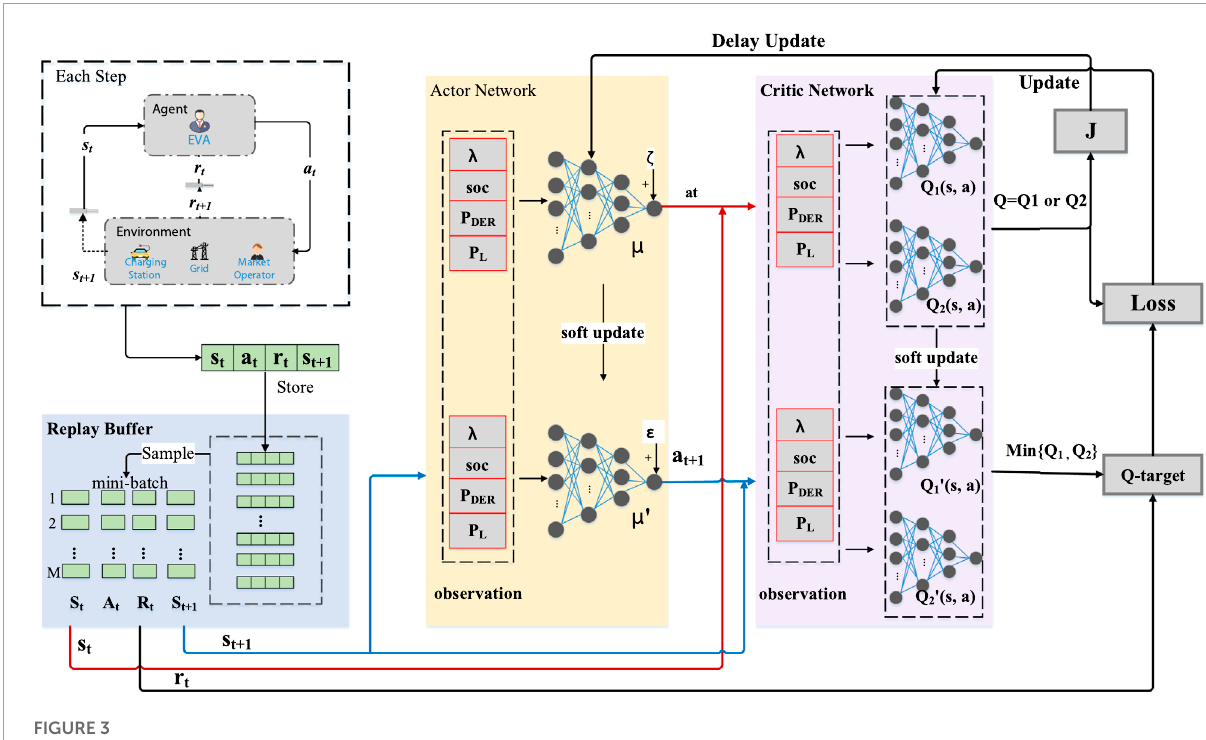
FIGURE 3 Training framework of